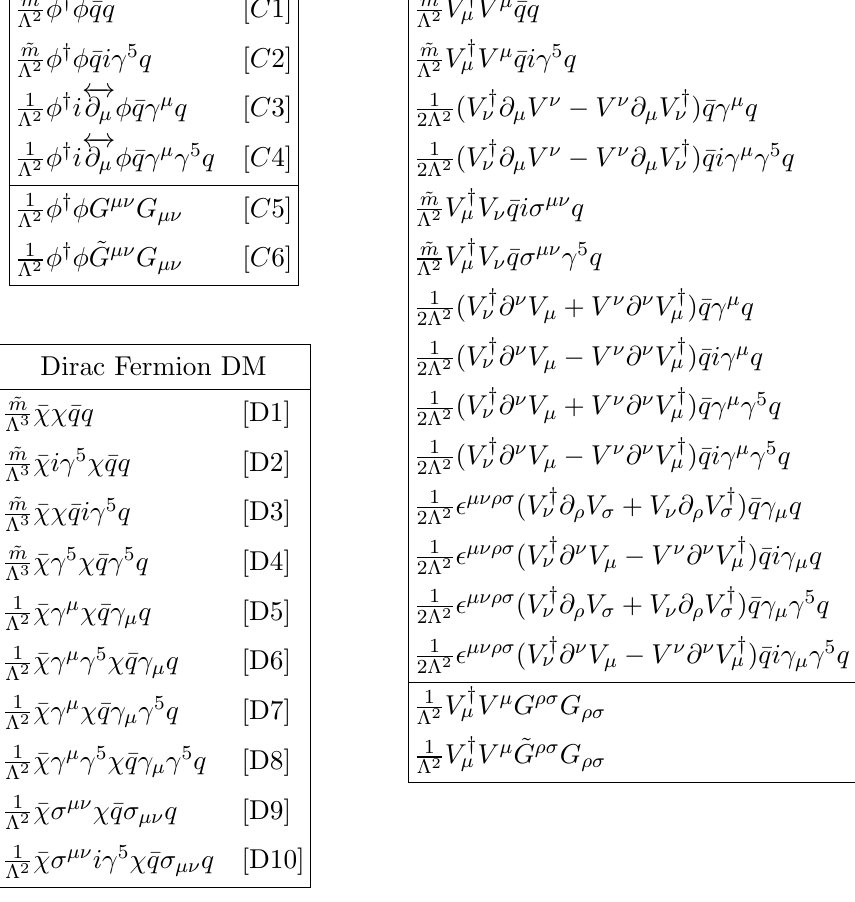
Table 1 . List of a minimal basis of EFT operators (dimension (cid:20) 6) involving only complex scalar DM ( (cid:30) ), Dirac fermion DM ( (cid:31) ) or complex vector DM ( V (cid:22) ) interacting with SM quarks ( q ) or gluons (through the (cid:12)eld strength tensor G (cid:22)(cid:23) and its dual ~ G (cid:22)(cid:23)